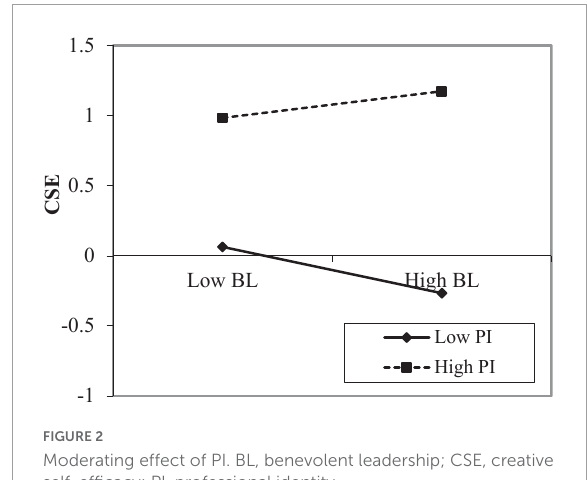
FIGURE2 Moderating effect of PI. BL, benevolent leadership; CSE, creative self-efficacy; PI, professional identity.